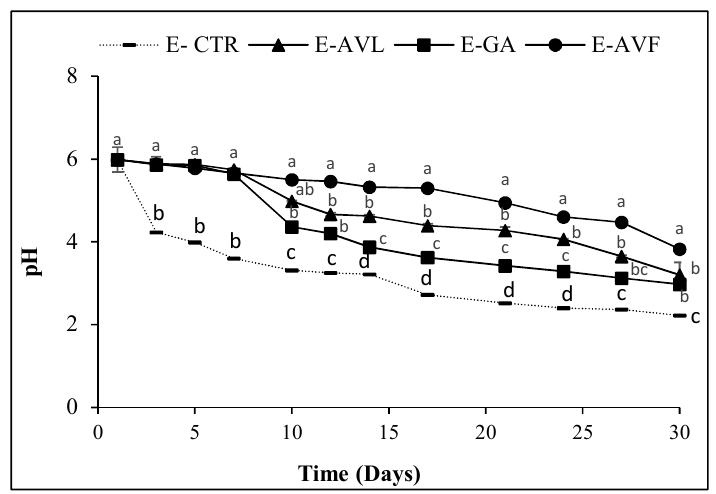
Figure 2. pH evolution during 30 days of study. E-CTR (Control emulsion sample), E-AVL ( A. vulneraria leaf emulsion sample), E-GA (Galic acid emulsion sample), E-AVF ( A. vulneraria flower emulsion sample). Error bars represent the standard deviation ( n = 3) and different letters in the same day indicate significant difference between samples at p < 0.05.